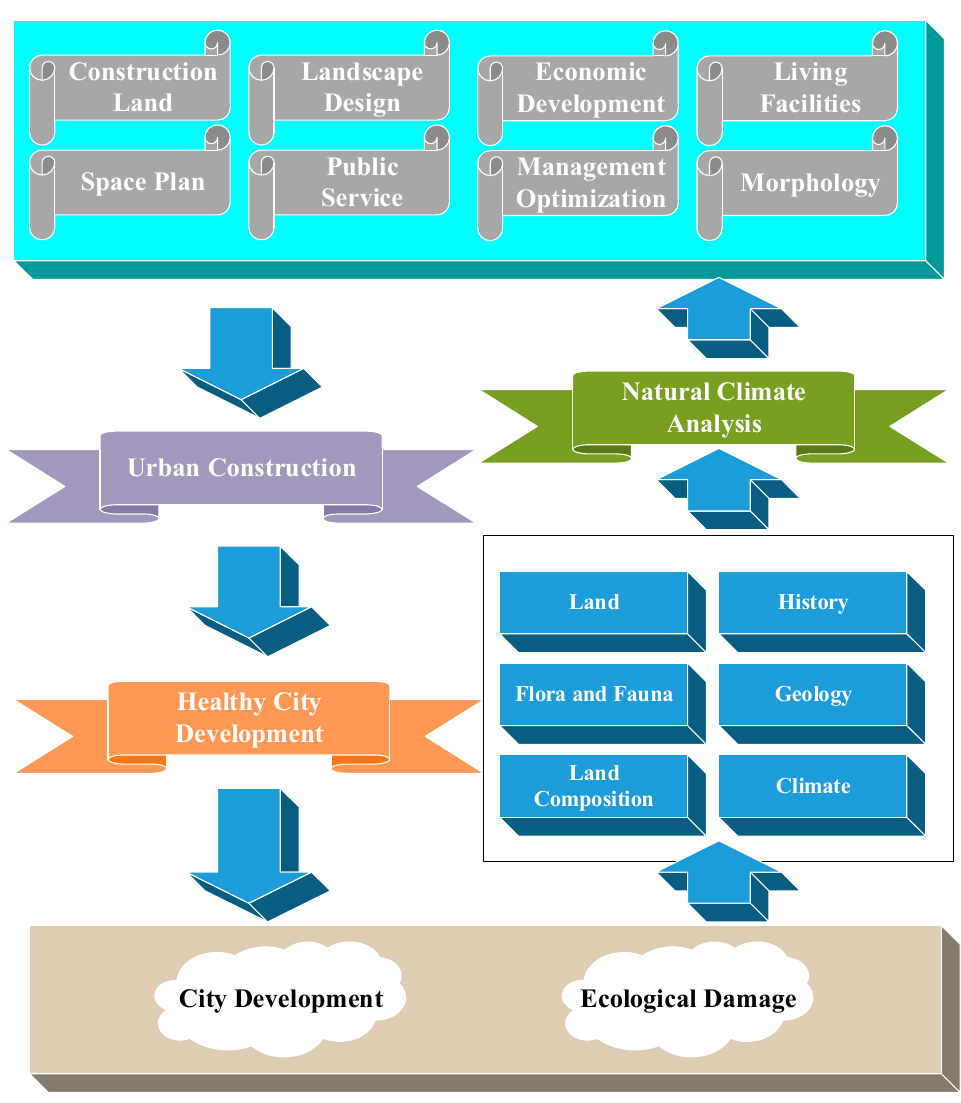
Figure 3. Healthy city’s community spatial structure planning. According to the concept of “three areas and two channels”, healthy urban planning divides the community space into three levels: block, residential area, and group, with public roads running through them. The layout of the spatial form features an overall openness and specific enclosedness. Under such a layout, when respiratory diseases spread, the community space can be rapidly transformed into a three-level prevention and control system [22], as shown in Figure